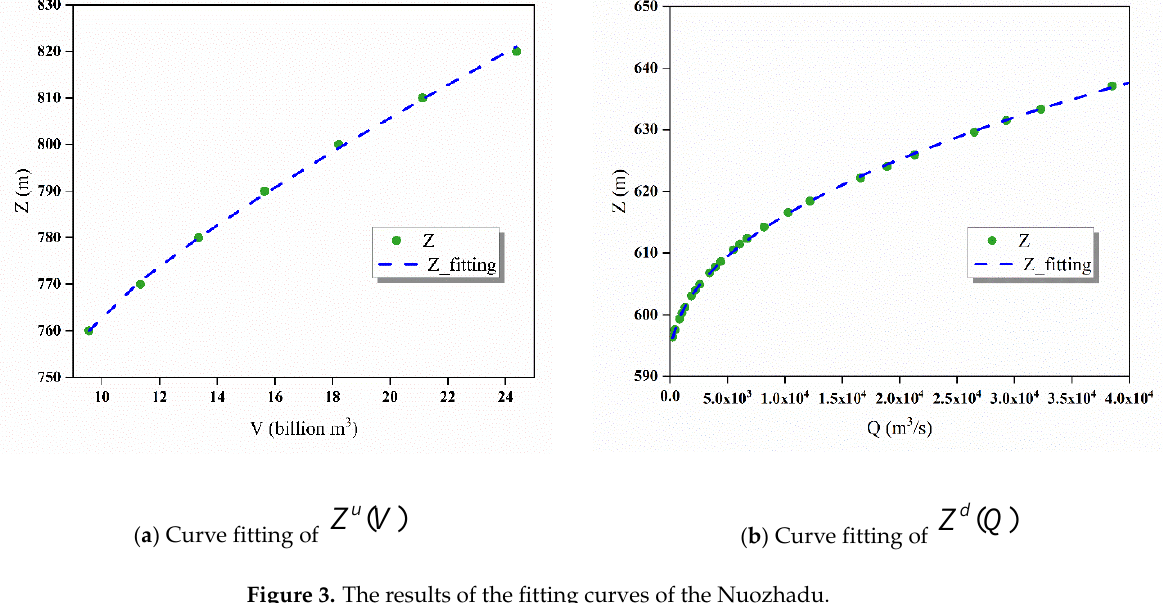
Figure 3. The results of the fitting curves of the